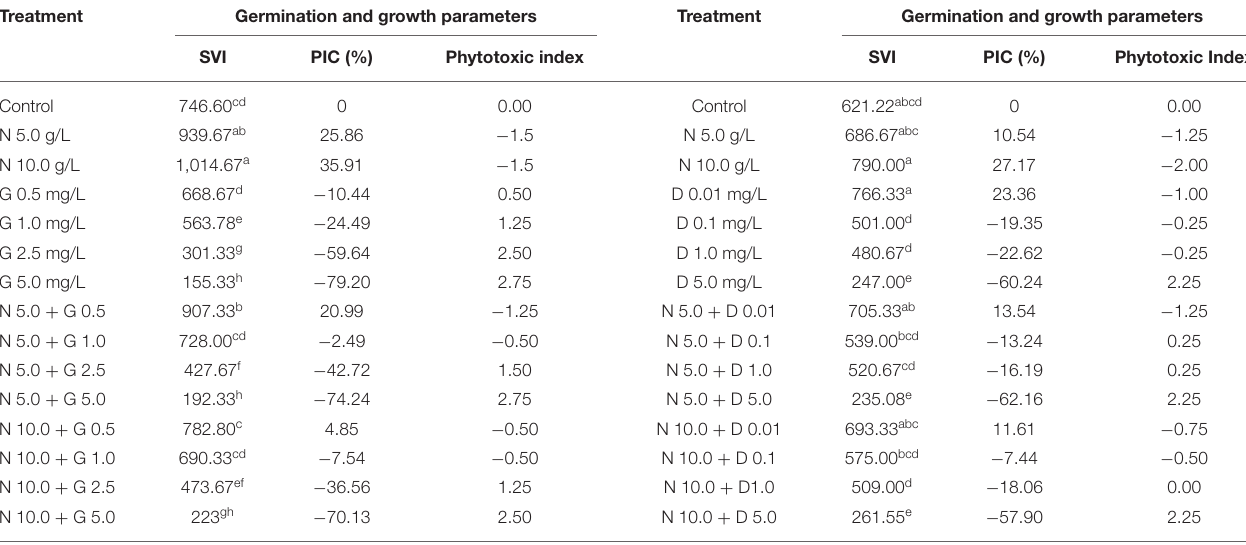
TABLE 3 | Effects of glyphosate, 2,4-D herbicides and Nostoc sp. N1 cells on the germination and growth parameters of 7-day-old rice seedlings.